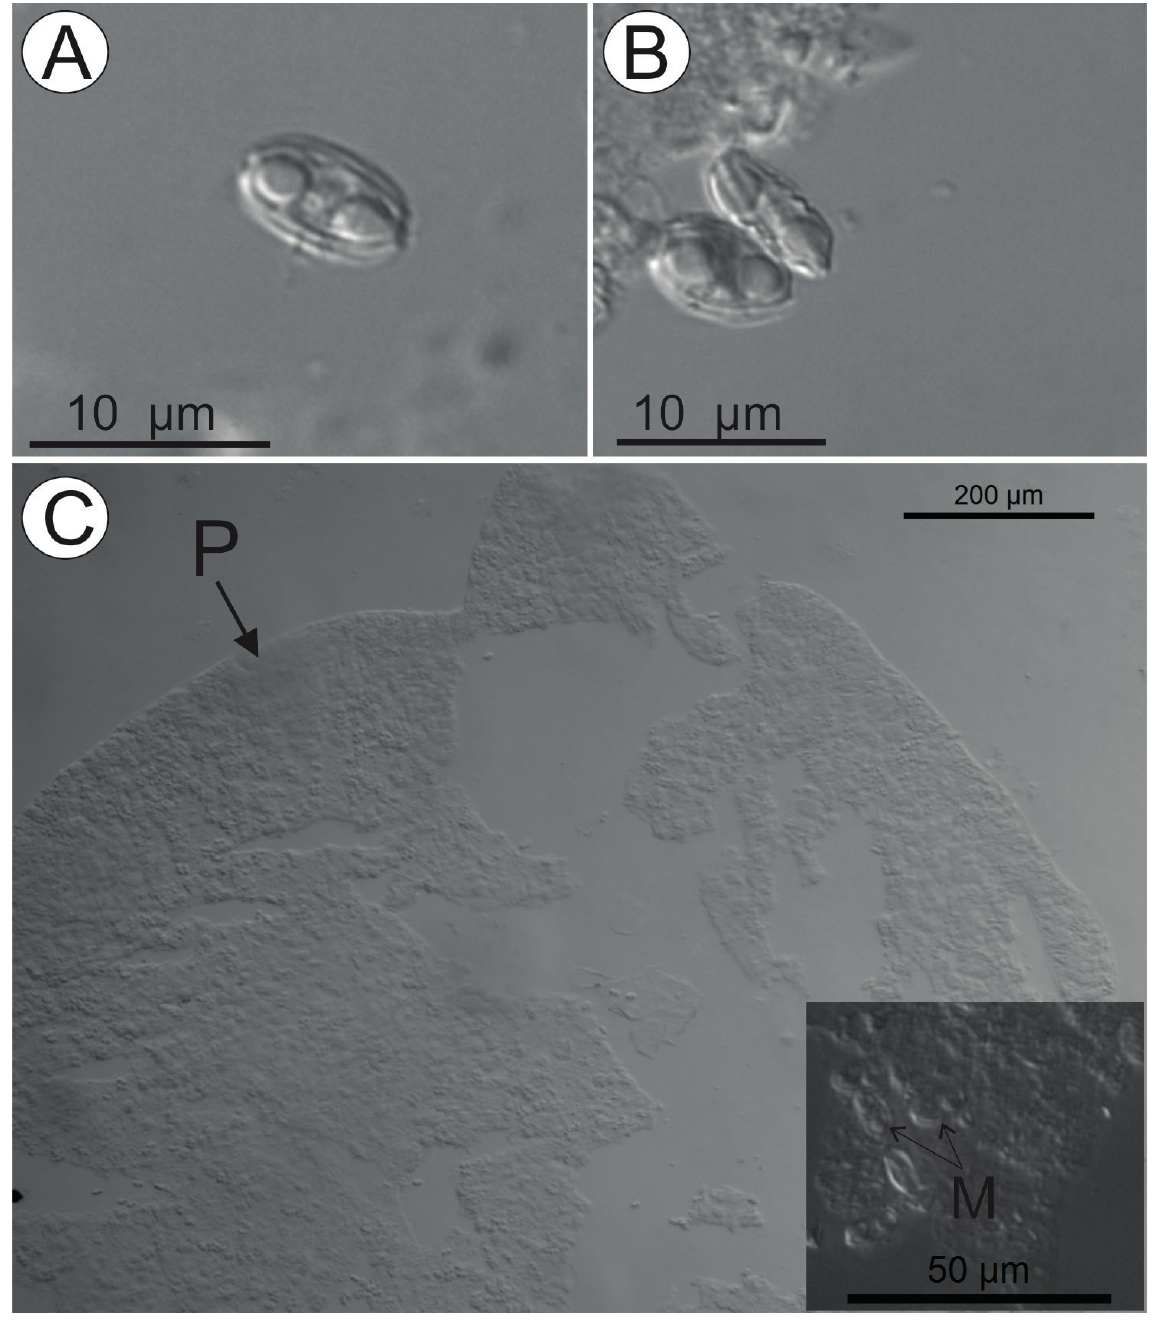
Fig. 1. Myxospores and pseudoplasmodia of Cystodiscus elachistocleis sp. nov. (INPA79) found parasitizing the gallbladder of Elachistocleis cesarii (Miranda-Ribeiro, 1920) from Araguaiana, Mato Grosso State, Brazil. A . Front view of C. elachistocleis sp. nov. B . Front and side view of C. elachistocleis sp. nov. C . Pseudoplasmodium (P) containing several myxospores of C. elachistocleis sp. nov. highlights myxospores (M) through the pseudoplasmodium-forming